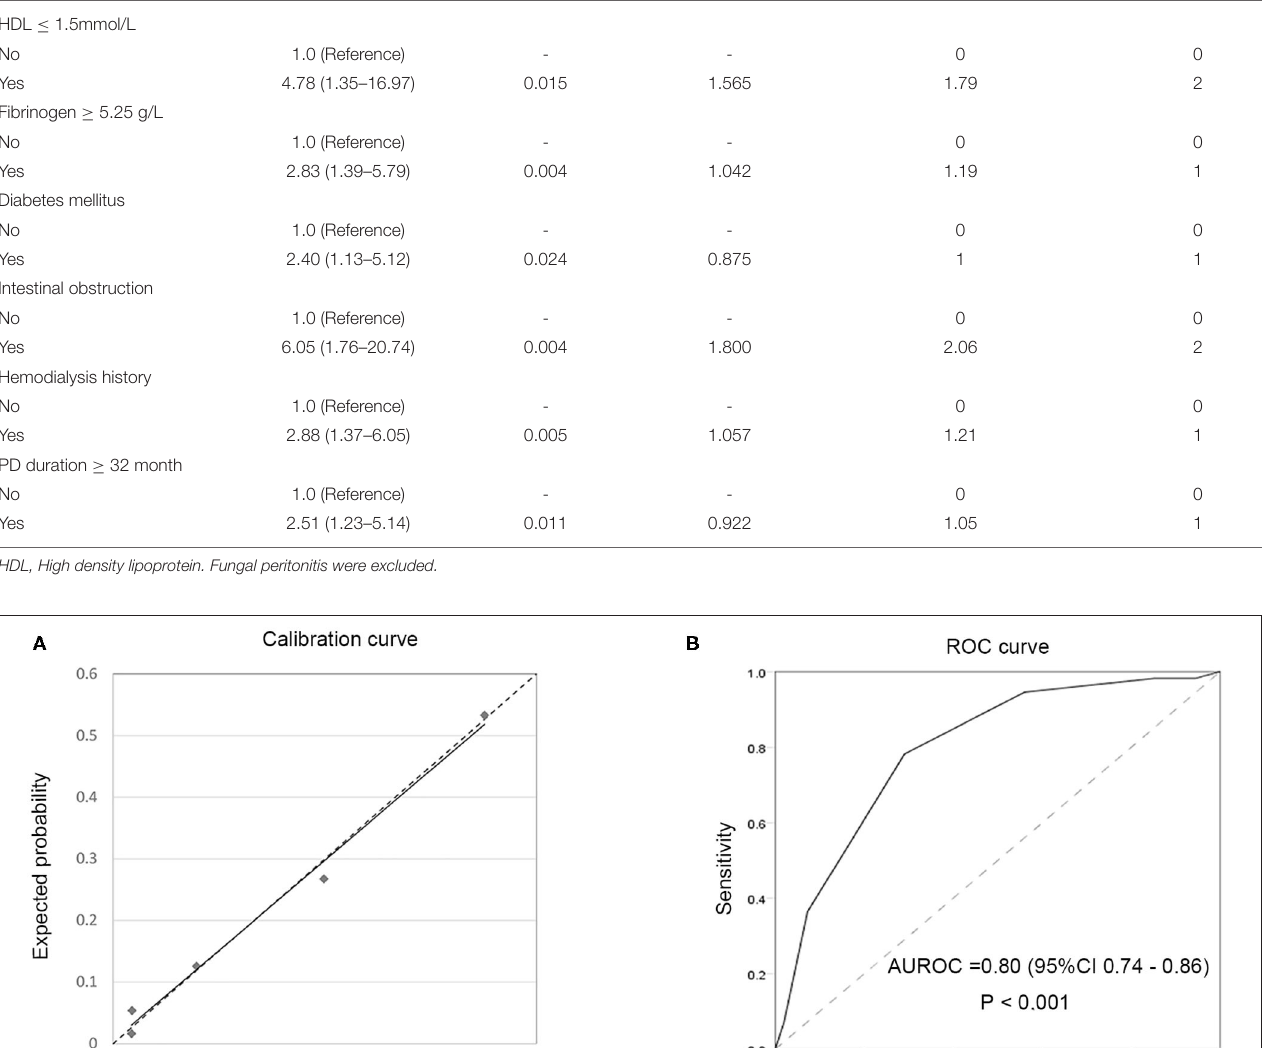
TABLE 4 | ß coefficient and corresponding risk score developed from risk prediction model. P -value ß-coefficients Transformed score Assigned score Risk factors Adjusted OR (95% CI)